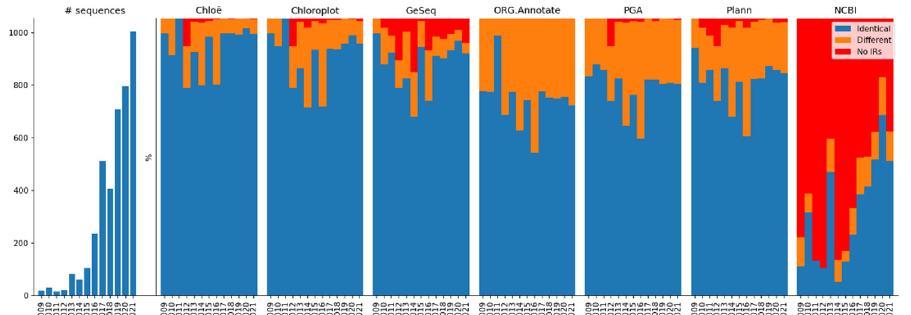
Figure 2. Number of complete chloroplast sequences added to GenBank per year (leftmost chart) and the relative ratio of the three types of sequences identified using six annotation tools (and those annotated in NCBI): blue—identical IRs, orange—different IRs, and red—no IRs.